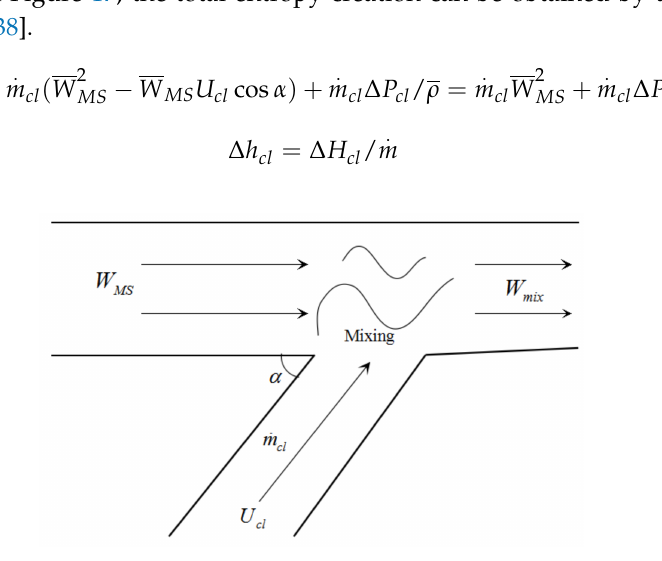
Figure 17. Mixing of injected flow with a mainstream